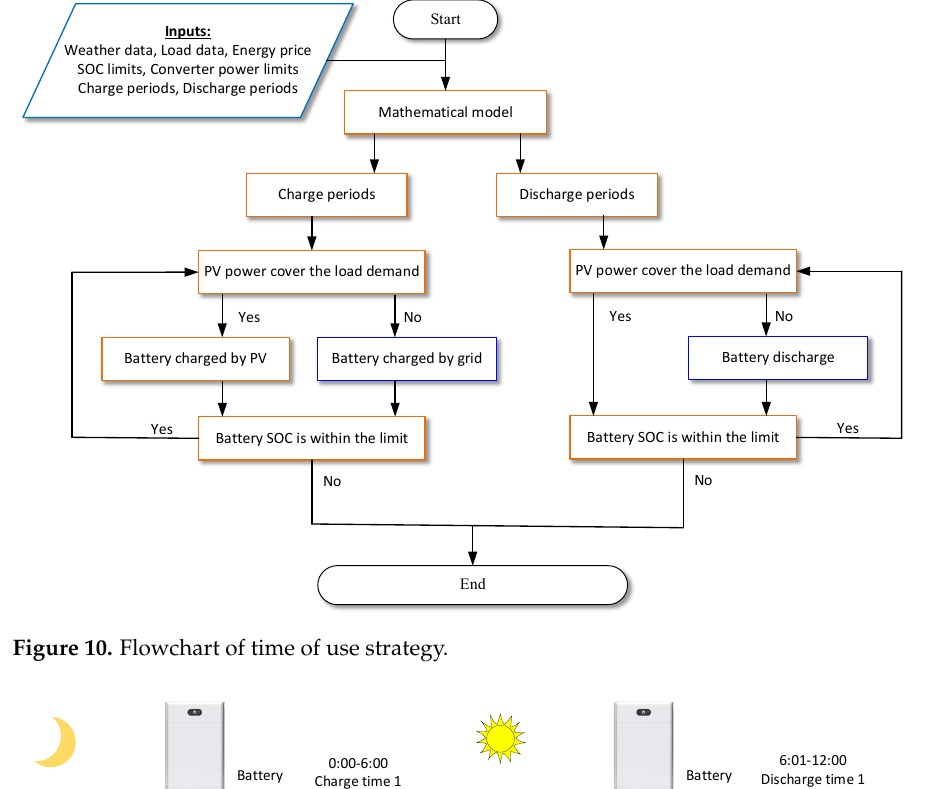
Figure 10. Flowchart of time of use strategy.